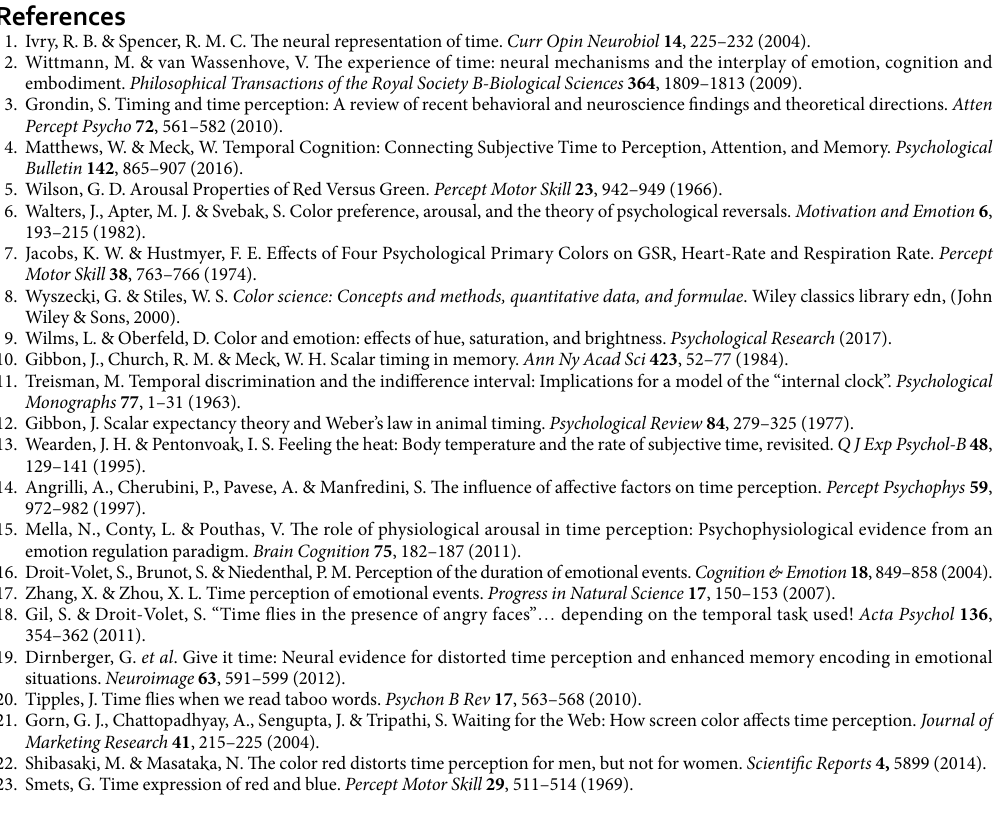
sessions, each lasting approximately 40 minutes. In each session, 288 trials of the duration-discrimination task were presented in random order. In session 1, participants received a short practice block (20 trials, randomly selected). In all sessions, the brightness of the red stimulus in the duration discrimination task was based on the individual brightness matches obtained in the first session. Before the beginning of the duration-discrimination task, in each session, the emotional responses to the blue and red stimulus were assessed by means of the nonverbal self-assessment manikin (SAM) scales 37 . The emotional dimensions valence, arousal, and dominance are illustrated by nine horizontally arranged pictograms each. From left to right, for the valence dimension, the scale ranges from a smiling, happy figure to a frowning, unhappy figure. For the arousal dimension, it ranges from an excited, wide-eyed figure to a relaxed, sleepy figure. For the dominance dimension, it ranges from a tiny to a large figure. A computer-based version of the scales was used. The scales were displayed with numerical labels ranging from “1” to “9”, respectively. For the arousal scale, “1” corresponded to “calm” and “9” to “aroused”. For the valence scale, “1” and “9” corresponded to “unpleasant” and “pleasant”, respectively. For the dominance scale, “1” and “9” corresponded to “submissive” and “dominant”, respectively. The nine numbers were vertically aligned with the centers of the nine pictograms. For each of the three scales, participants rated their emotional state by entering one of the integer numbers 1 to 9 on the numer- ical keypad. First, the blue stimulus was rated in terms of valence, arousal, and dominance. Subsequently, the red stimulus was rated accordingly. The SAM ratings were used as a manipulation check, in order to test whether the red stimulus induced more arousal than the blue stimulus. After the duration-discrimination task, in order to increase the reliability of the SAM-ratings, a second set of ratings for the two color stimuli was collected in each session. Data availability.